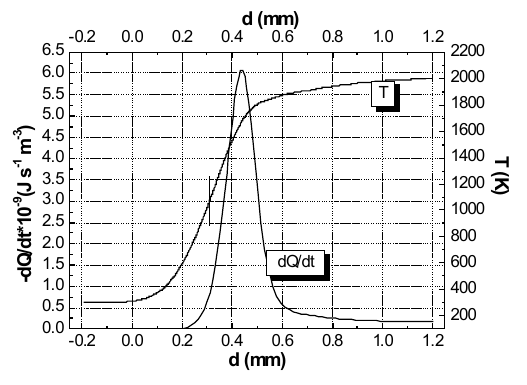
Figure 4. Temperature and volumetric rate of heat release profiles in the stoichiometric C